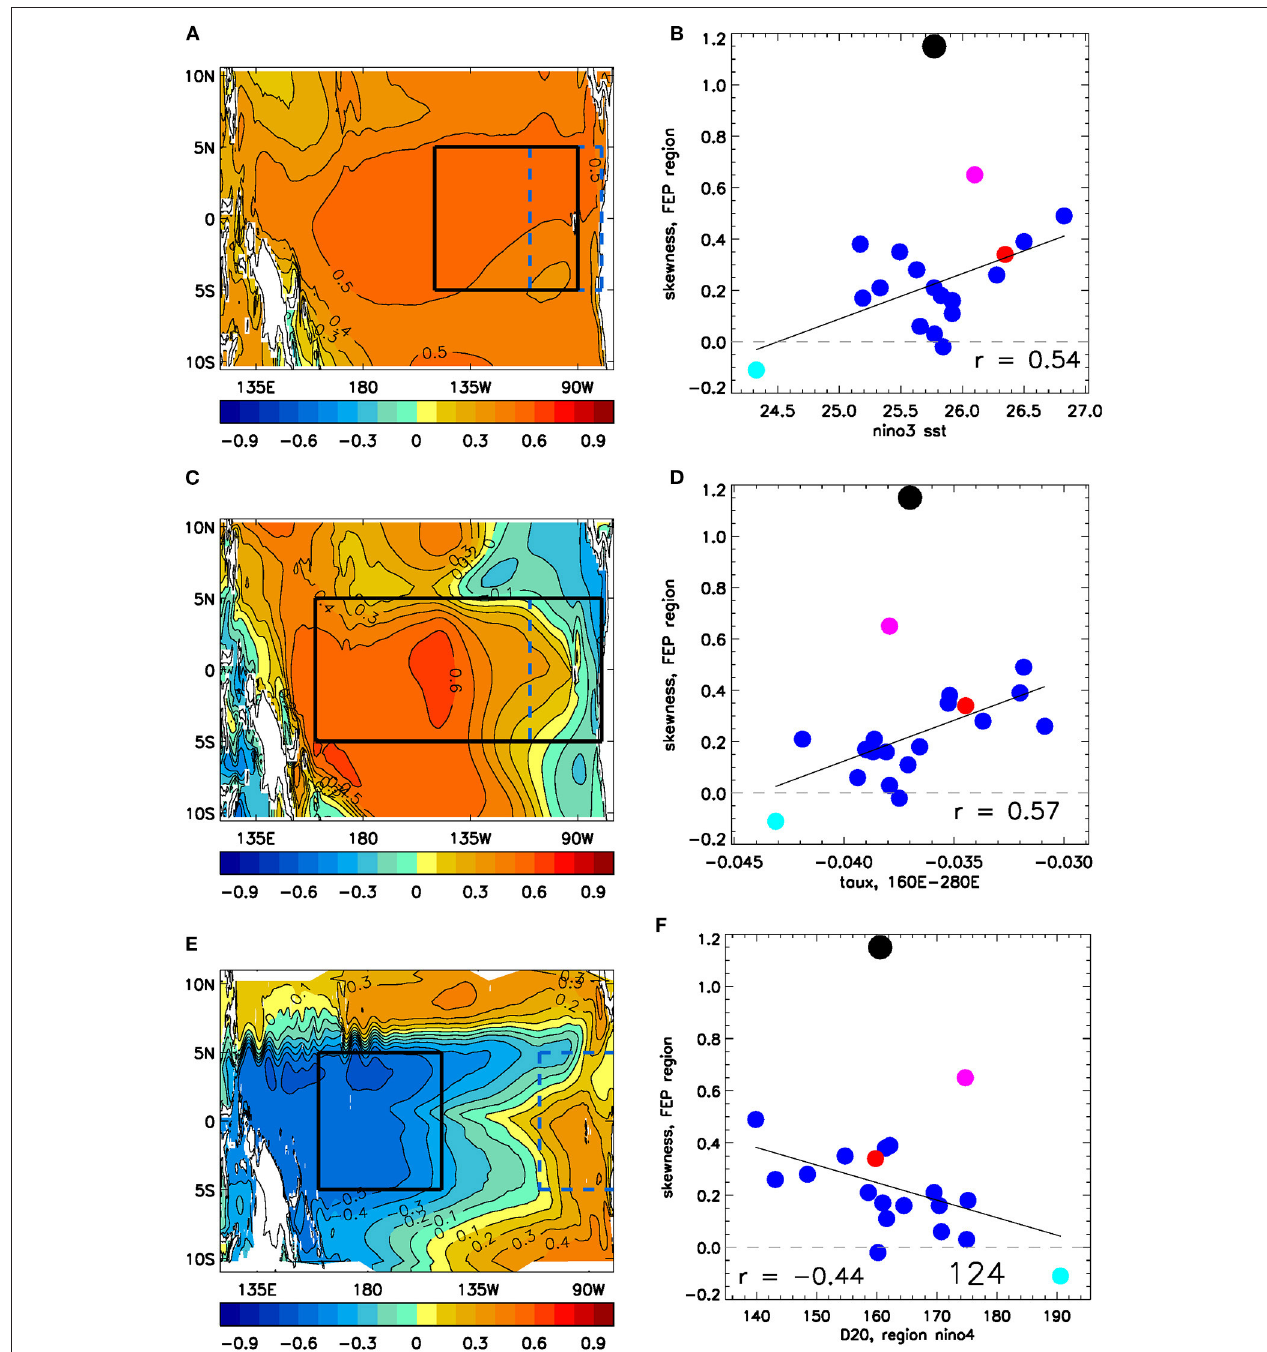
FIGURE 2 | Relationship between skewness and equatorial Pacific annual mean state. Spatial plot of grid point correlation of SST (A) zonal wind stress (C) and depth of 20 ◦ isotherm (E) with FEP skewness. Scatter diagram of FEP skewness against annual mean Niño3 SST (B) , central Pacific wind stress (D) and depth of 20 ◦ isotherm for region Niño4 (F) for PPE members (small blue circles, with SK + magenta, STD red, SK- cyan) and reanalysis data (large black circle). Regions for FEP (110-80 ◦ W, 5 ◦ N-5 ◦ S), Niño3 (150-90 ◦ W, 5 ◦ N-5 ◦ S), central Pacific (160 ◦ E-80 ◦ W, 5 ◦ N-5 ◦ S) and Niño4 (160 ◦ E-150 ◦ W, 5N-5S) are shown by boxes in the left-hand